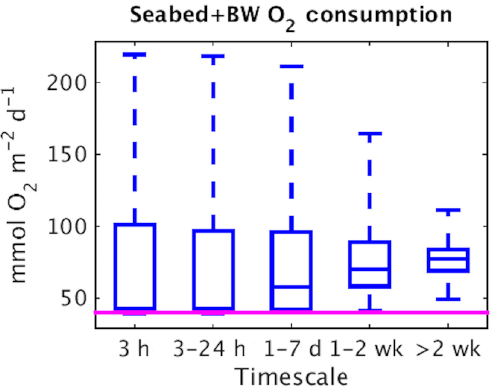
Figure 8. Box and whisker plot indicating the 0th, 25th, 50th, 75th, and 100th percentiles of combined seabed–bottom-water (BW) oxy- gen consumption averaged over different timescales for the stan- dard model run. The pink lines indicate estimates from the no- resuspension model